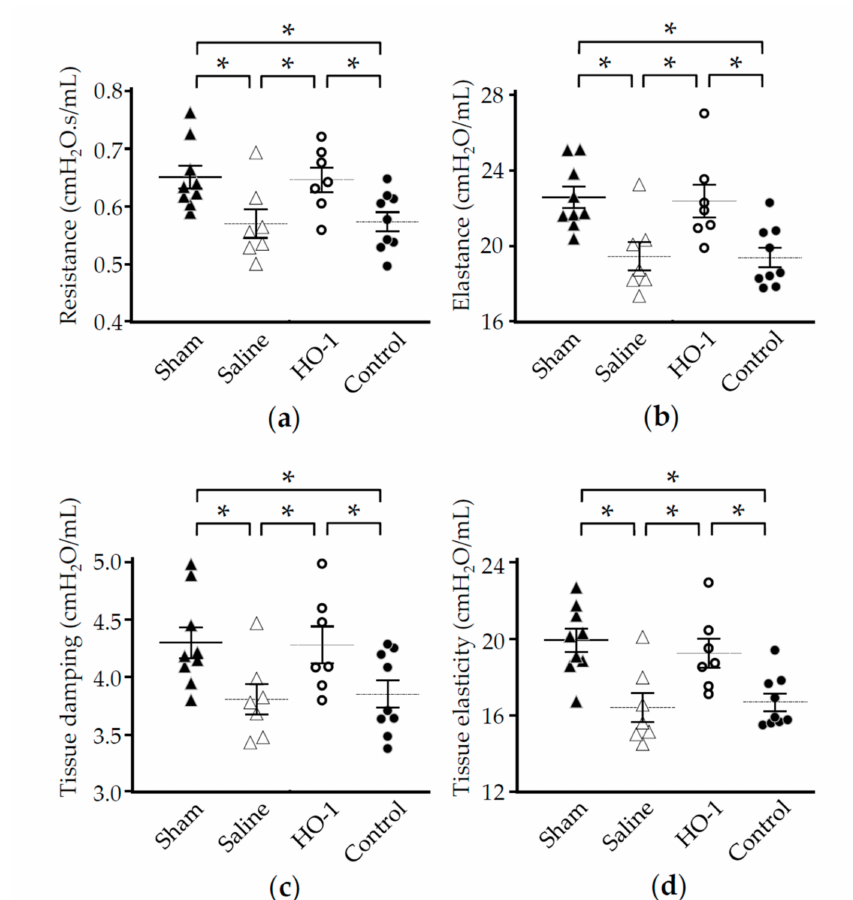
Figure 9. E ff ect of nasal administration of HO-1 lactis on PPE-induced deterioration in pulmonary function. Mice were treated as described in Figure 5. Pulmonary function tests were performed under anesthesia using a flexiVent system on day 21. The parameters of ( a ) resistance and ( b ) elastance were measured by snapshot perturbation, indicating function, including the whole thorax. The parameters of ( c ) tissue damping (resistance) and ( d ) tissue elasticity were measured by forced oscillation primewave-3 perturbation, indicating the function of the lung tissue (peripheral airways). The averages of three acceptable maneuvers in each mouse are shown as individual measurements. Bars indicate the mean ± SE. The data were collected from 2–3 independent experiments involving a total of 7 to 9 mice / group. *, p <